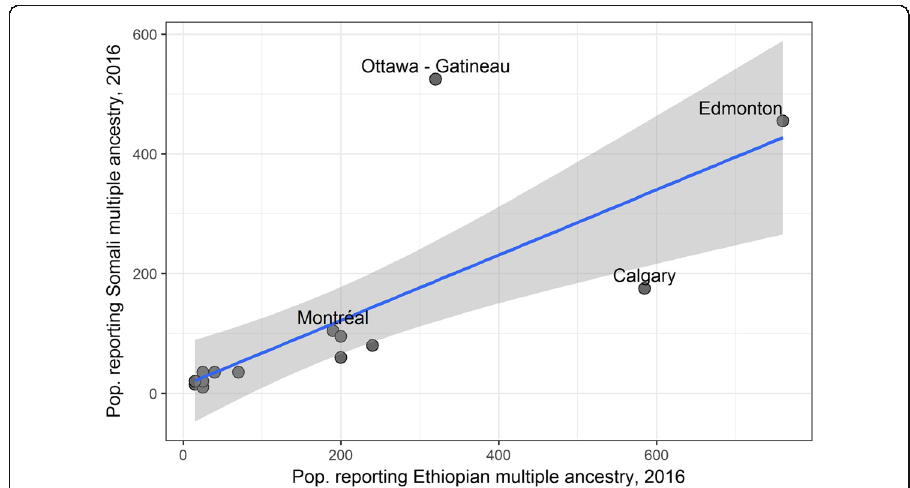
Fig. 12 Population reporting Somali multiple ethnicity plotted against population reporting Ethiopian ethnicity in 2016, selected metropolitan areas (excluding